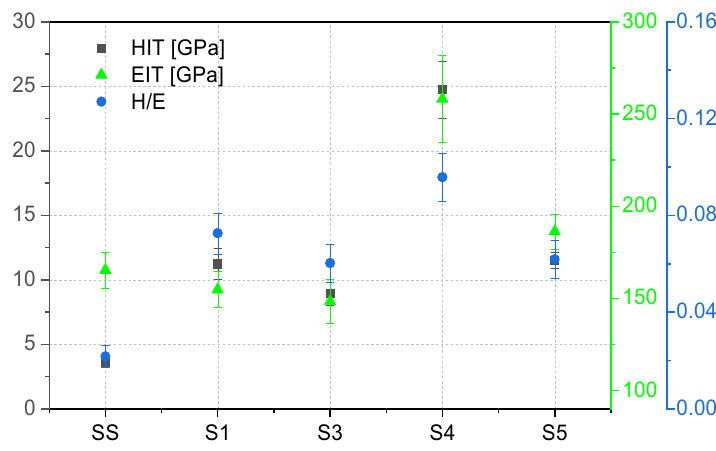
Figure 9. Nanoindentation results; S4 film expresses the highest HIT.